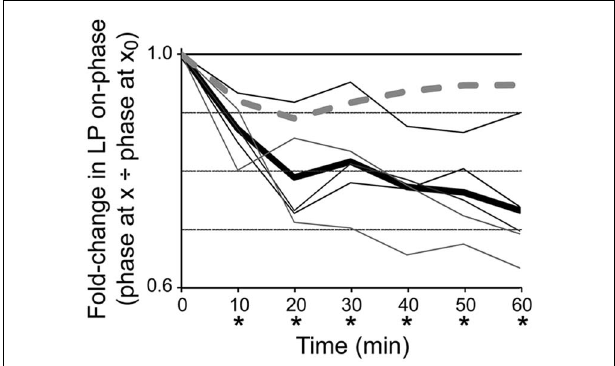
FIGURE 4 | DAD regulation of LP I h is necessary for phase recovery in 5 μ M. Plots of fold-changes in LP-on phase over time for dynamic clamp (solid lines) and control (dashed line) experiments indicate that introduction of a dynamic clamp current to abrogate DAD regulation of LP I h prevents phase recovery; thin lines, individual experiments with dynamic clamp ( n = 5); thick line, average for experiments with dynamic clamp; dashed line, control experiment that was exactly the same as the dynamic clamp experiments except that the dynamic clamp was turned off during the 1 h superfusion with 5 μ M DA. Repeated measures ANOVA with Dunnett’s post hoc tests that compared all time points to t = 0 showed that average LP-on phase did not recover in experimental preparations, F (6,4) = 16.04, p < 0.0001; * p < 0.05. Note that phase did recover in the control